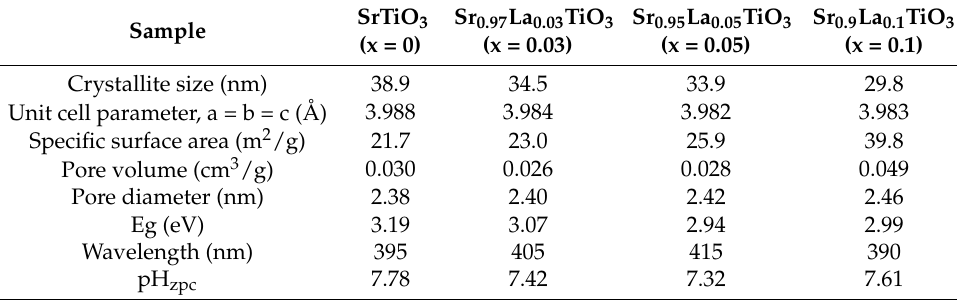
Table 2. Physical parameters of the Sr 1 − x La x TiO 3